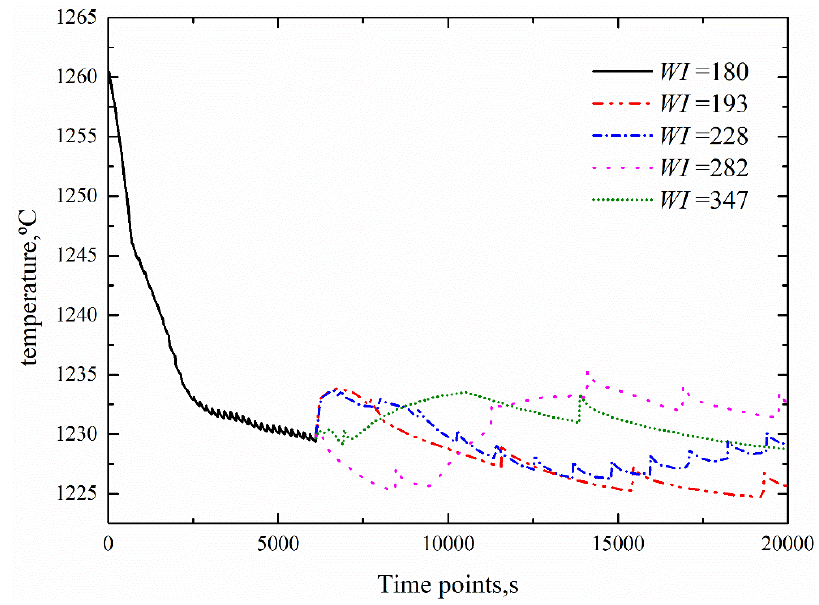
Figure 11. Comparison of drop-out temperature of slab with different walking intervals. WI : walking Comparison of drop-out temperature of slab with different walking interval.